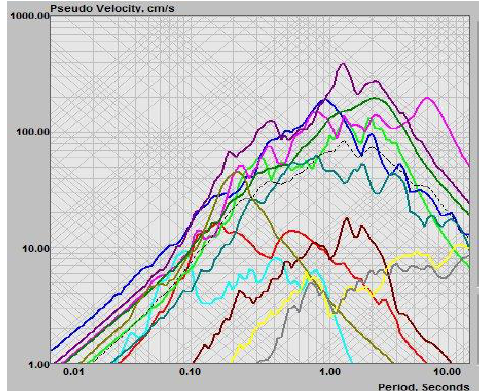
Fig. 12. Pseudo velocity spectrum for used ground motion records.